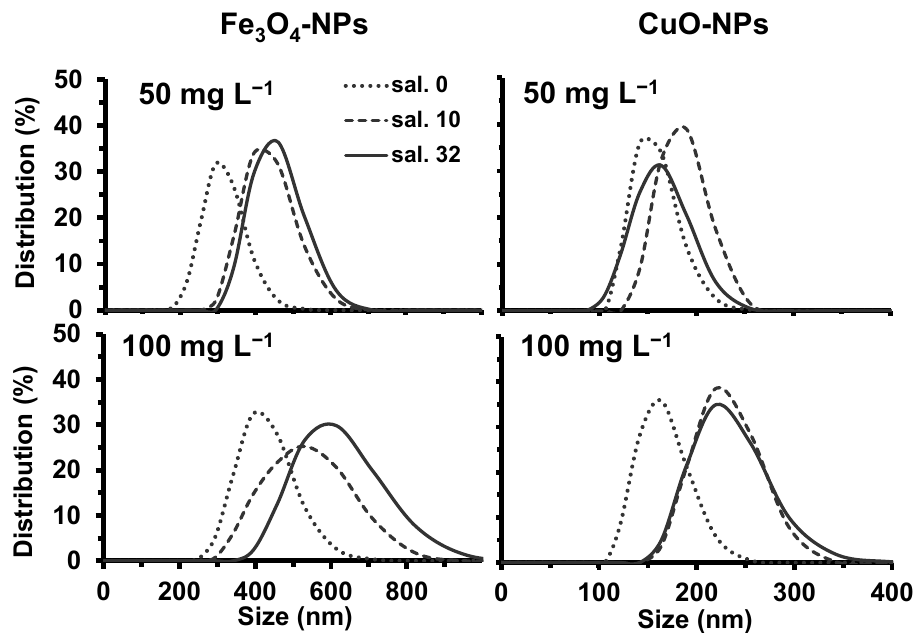
Figure 2. Hydrodynamic diameter distribution of Fe 3 O 4 and CuO particle size in HSM (dots), and under two salinity conditions, 10 g L − 1 (dash) and 32 g L − 1 (line).